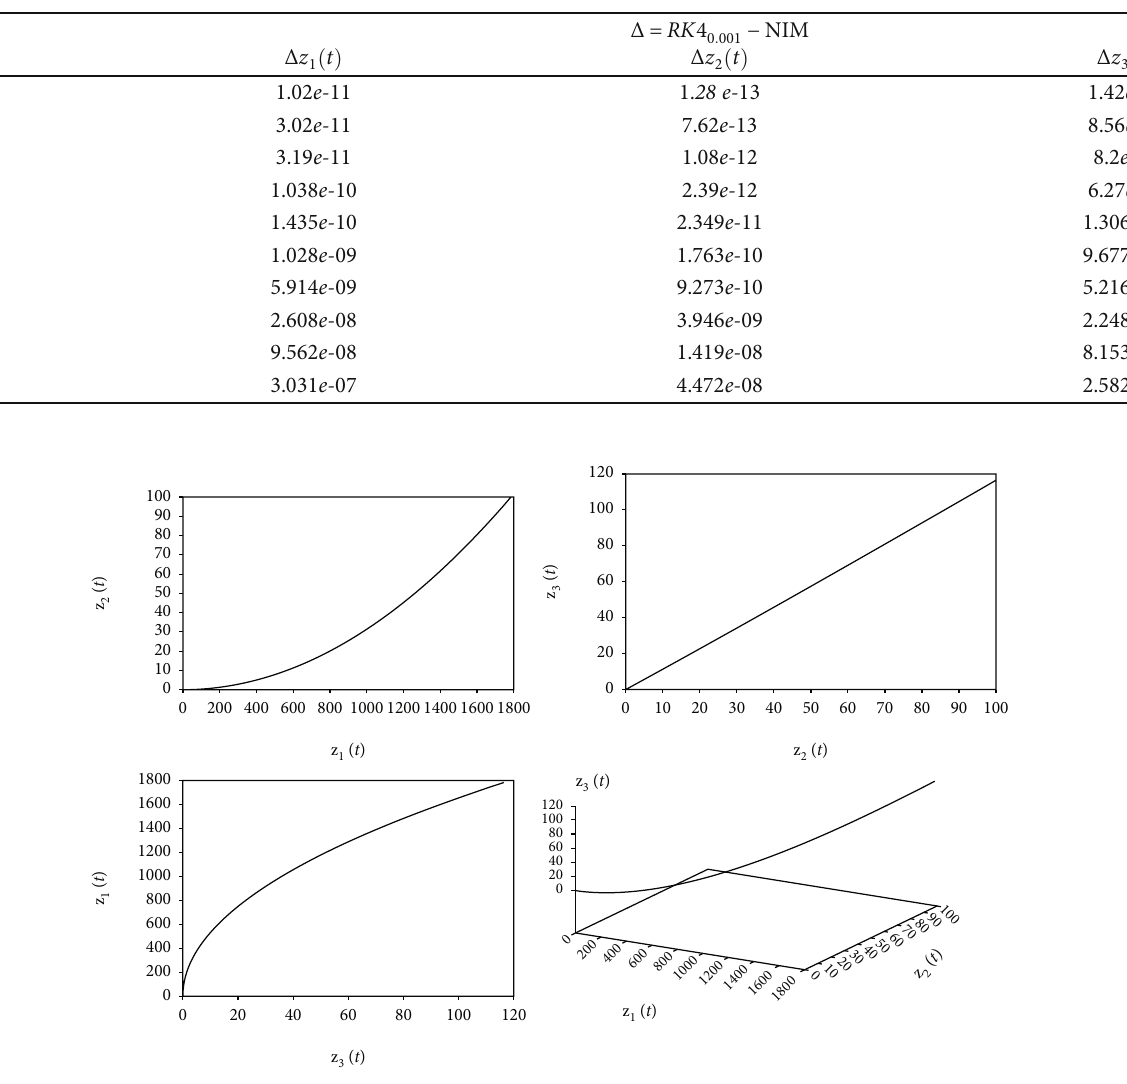
Table 2: Di ff erences between 9-iteration NIM with RK4 solutions in the impulse input